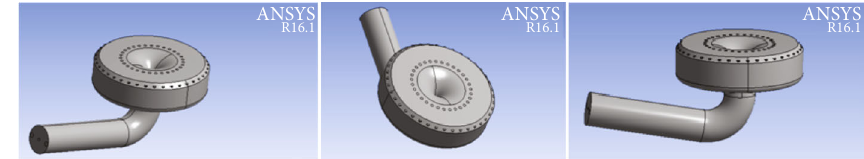
Figure 2: 3D geometry of a burner.